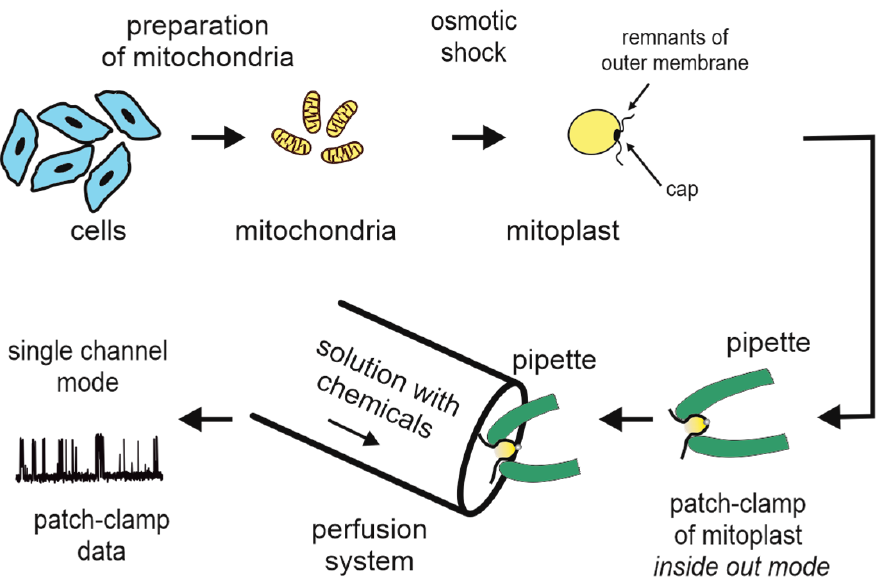
Figure 3. Patch-clamp technique in mitochondrial K + channel studies. Schematic representation of the preparation of mitochondria and mitoplasts and the patch-clamp experiment in inside-out mode with a perfusion system.